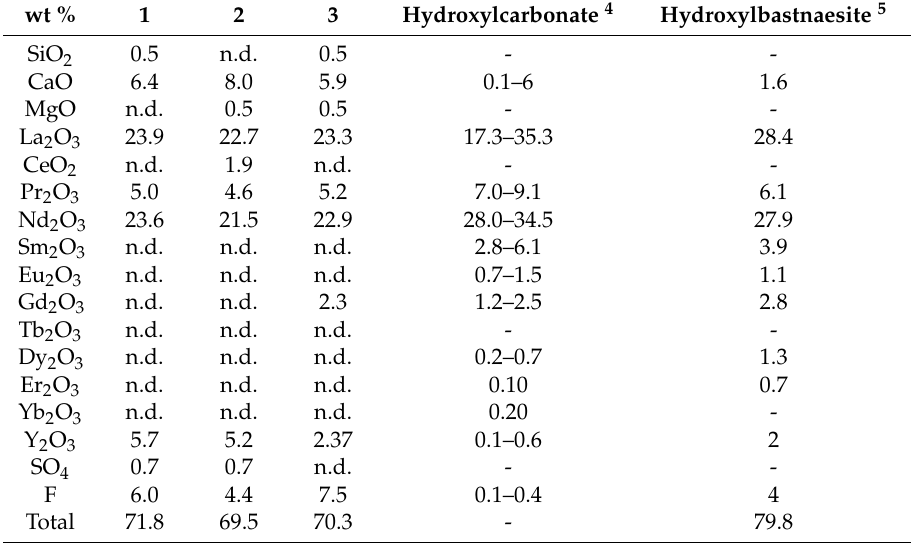
Table 6. Representative scanning electron microscope-energy dispersive spectroscopy (SEM-EDS) analyses of authigenic REE minerals from the Nissi (Patitira) bauxite laterite deposit. Data for 4, 5 from [10].